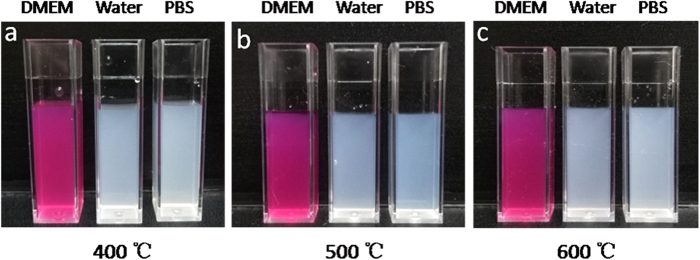
Photographs of ZrO2 NPs dispersions in DMEM, Water, PBS.ZrO2 NPs were synthesized at different temperatures (a) 400 °C, (b) 500 °C, and (c) 600 °C.